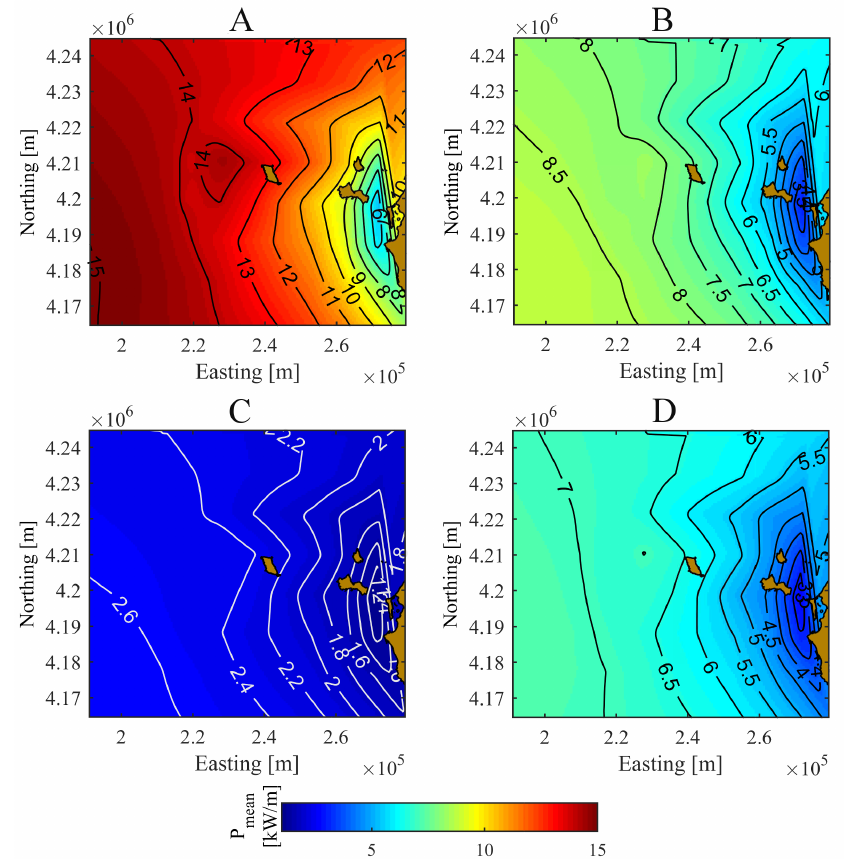
Figure 10. Distribution of the average wave energy flux of Aegadian islands area (ED50-UTM33N). The isolines represents the wave energy flux [kW/m]. ( A ) winter months (December, January,